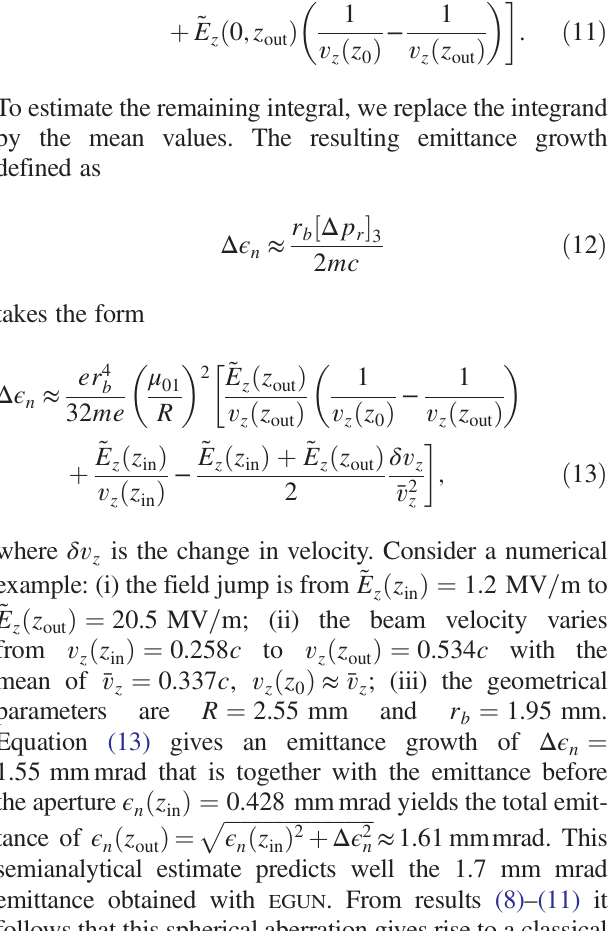
FIG. 17. The normalized rms emittance in mm mmrad for a flat and concave cathode vs. the longitudinal distance. The thermal emittance is shown as a